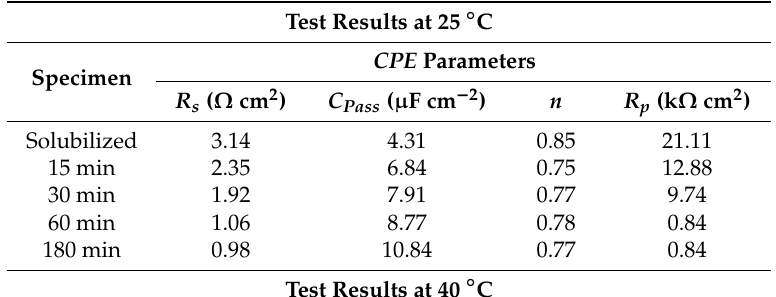
Table 3. EIS Fitting parameters. Test Results at 25 ◦